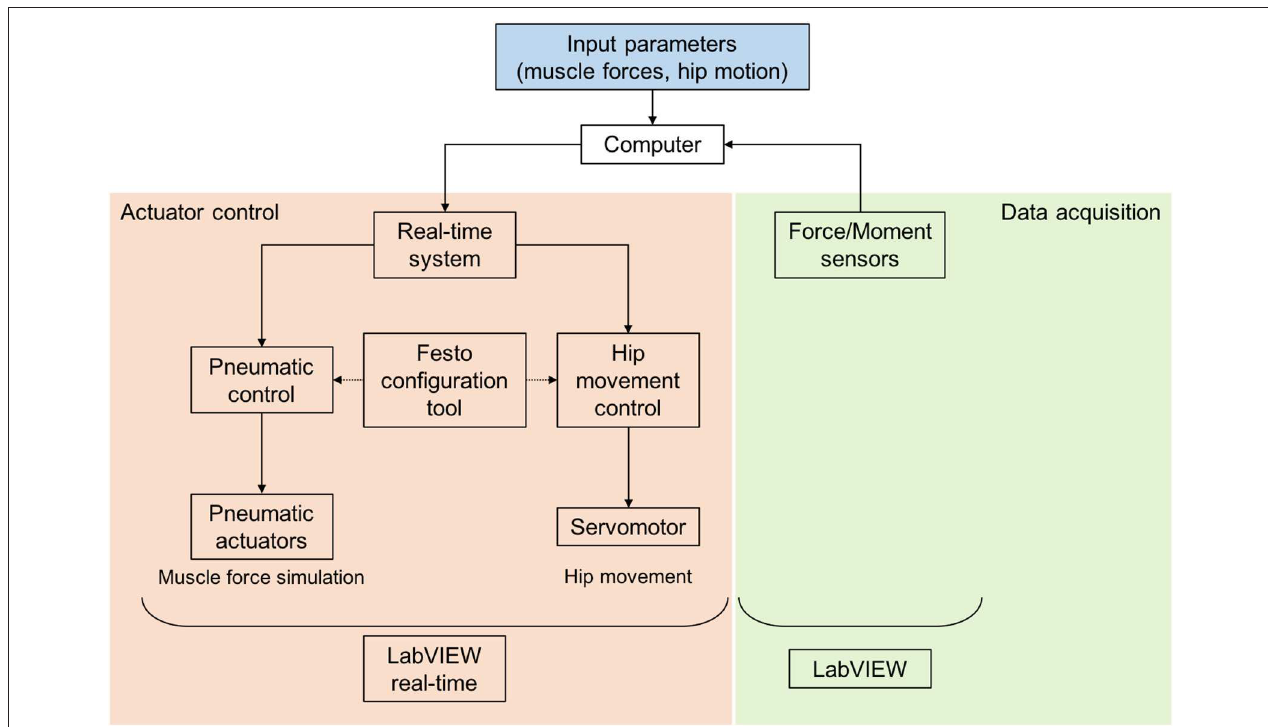
FIGURE 2 | Control of the dynamic knee joint simulator with a real-time system, Festo configuration tool for parameterisation, control of the pneumatic and electrical actuators, registration of force sensors and LabVIEW and LabVIEW real-time applications.